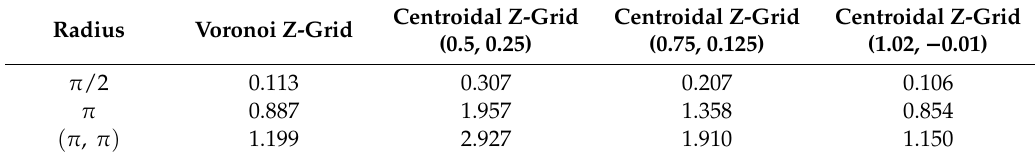
Table 1. Dispersion relation di ff erence between discrete and continuous dispersion relations. Centroidal Z-Grid Centroidal Z-Grid Centroidal Z-Grid Radius Voronoi Z-Grid (0.5, 0.25) (0.75, 0.125) (1.02, − 0.01) π /2 0.113 0.307 0.207 0.106 π 0.887 1.957 1.358 0.854 ( π , π ) 1.199 2.927 1.910